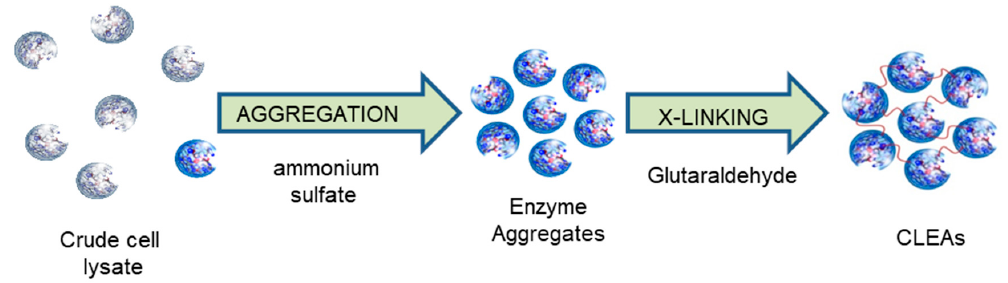
Figure 1. Cross-linked enzyme aggregate (CLEA) preparation.